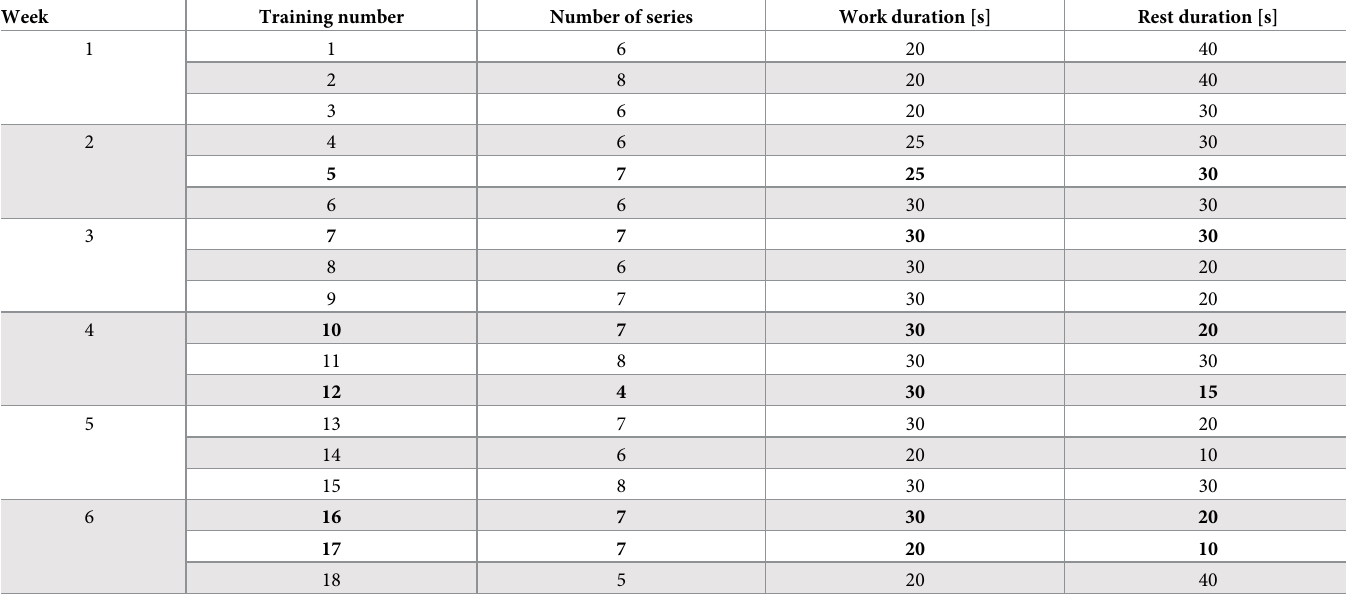
Table 2. Detailed parameters of the training sessions.